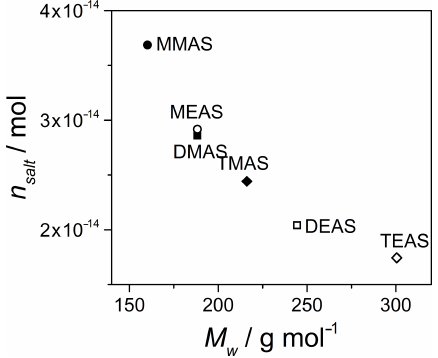
Figure 4. Moles of salt ( n salt ) in a 1µm radius solid particle as a function of the molecular weight ( M w ) of each aminium